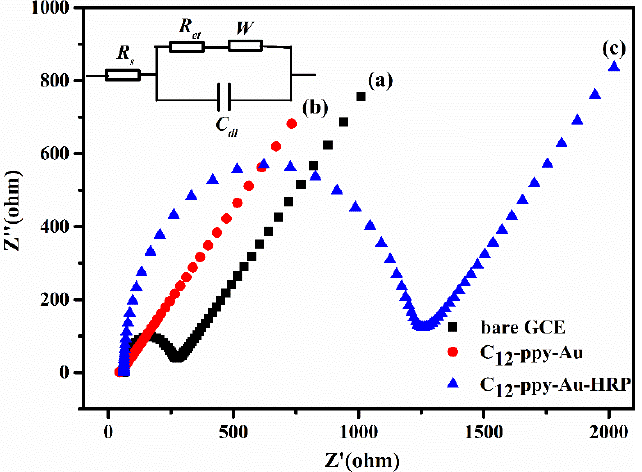
Figure 7. EIS responses of stepwise modified GCE ( a ) bare GCE, ( b ) C 12 -PPy/GCE, ( c ) C 12 -PPy-Au- HRP/GCE in 0.01 M PBS containing 5 mM Fe[(CN) 6 ] 3−/4− and 0.1 M KCl (pH 7.0).